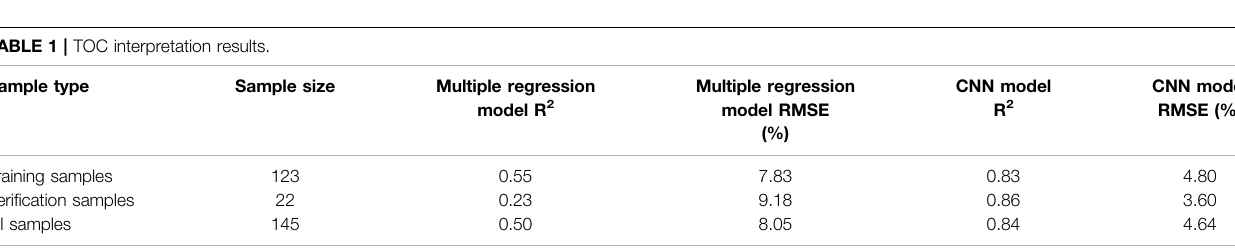
TABLE 1 | TOC interpretation